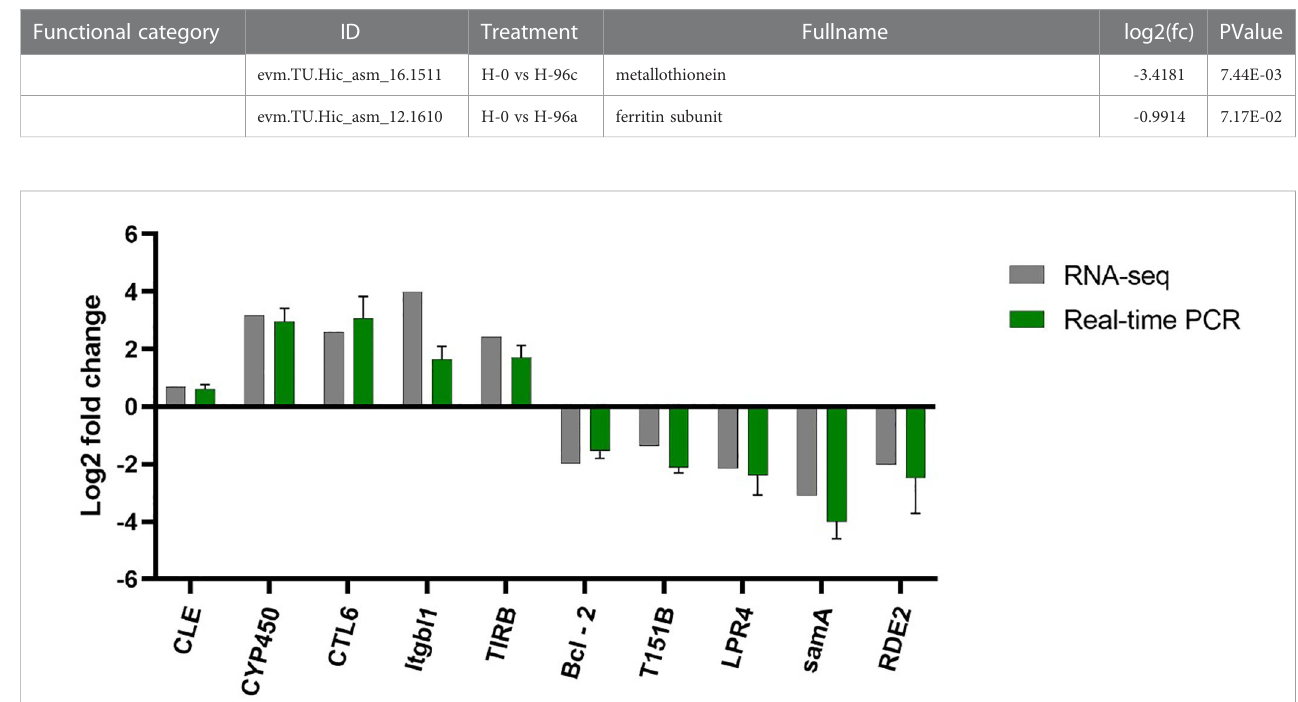
FIGURE 8 Transcriptome result validation. RNA seq and Real-time PCR are shown in grey and green,